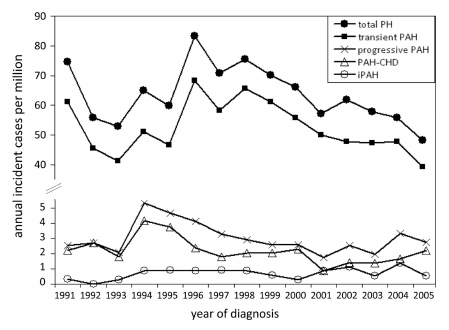
Figure 3. Annual incidence rates for pediatric pulmonary hypertension. PH indicates pulmonary hypertension; PAH, pulmonary arterial hypertension; PAH-CHD, PAH associated with congenital heart defects; and IPAH, idiopathic PAH [14].